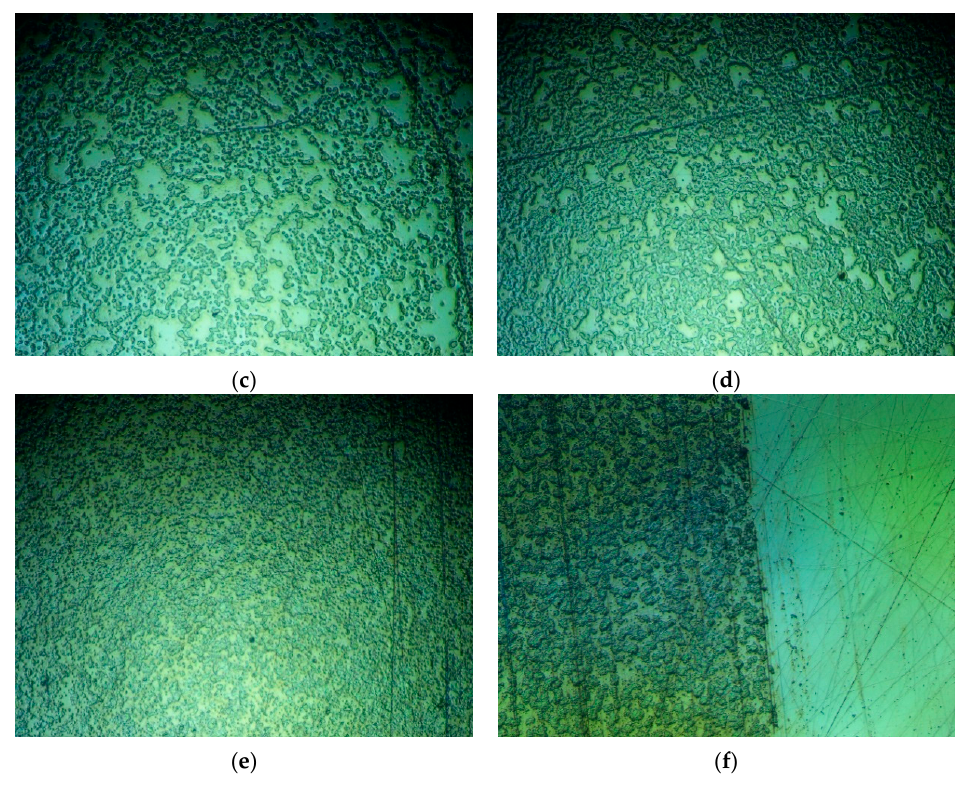
Figure 3. Time evolution of the biofilm produced by S. epidermidis ATCC 35984 on the gold electrode of the AT-cut crystal sensor. ( a ) 45 min; ( b ) 90 min; ( c ) 180 min; ( d ) 330 min; ( e ) 24 h; ( f ) 24 h with a cleaned area on the right.